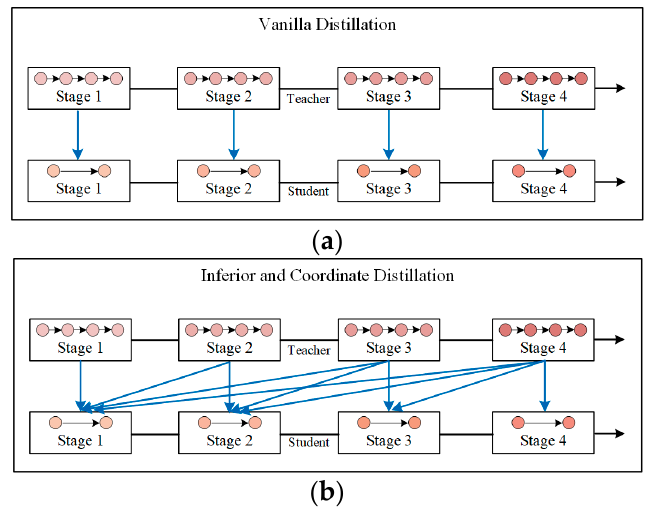
Figure 1. Comparison between vanilla distillation ( a ) and inferior and coordinate distillation ( b ).